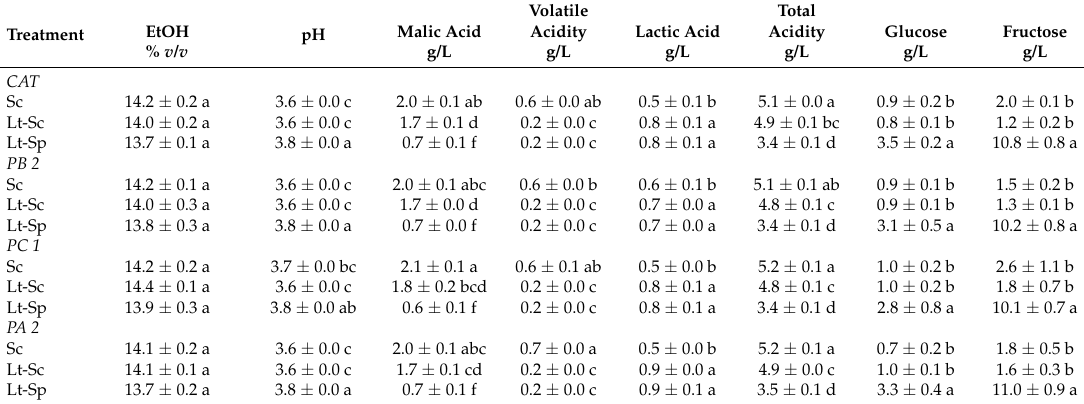
Table 1. Ethanol, acidity and sugar content in wine samples. Results are shown by treatment. The statistical analysis was performed by parameter (columns) and the different letters indicate significant statistical difference (LSD method with method with 95% confidence level). Means ± standard deviation (STD) ( n =